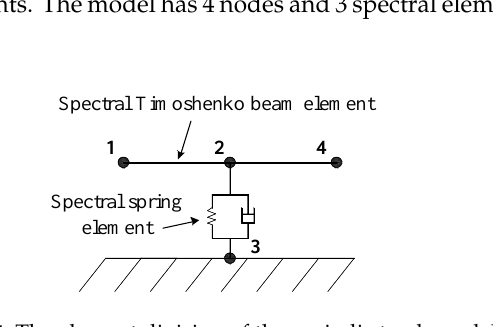
Figure 7. The element division of the periodic track model.